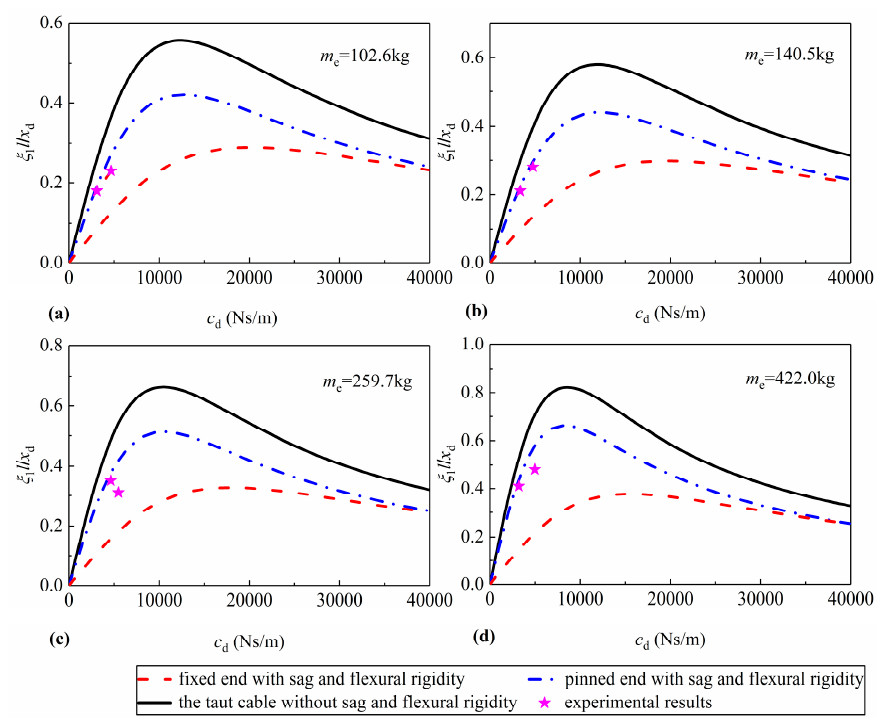
Figure 2. Comparison between the theoretical and experimental supplemental modal damping ratios in the first mode of the cable: ( a ) m e = 102.6 kg; ( b ) m e = 140.5 kg; ( c ) m e = 259.7 kg ( d ) m e = 422.0 kg.